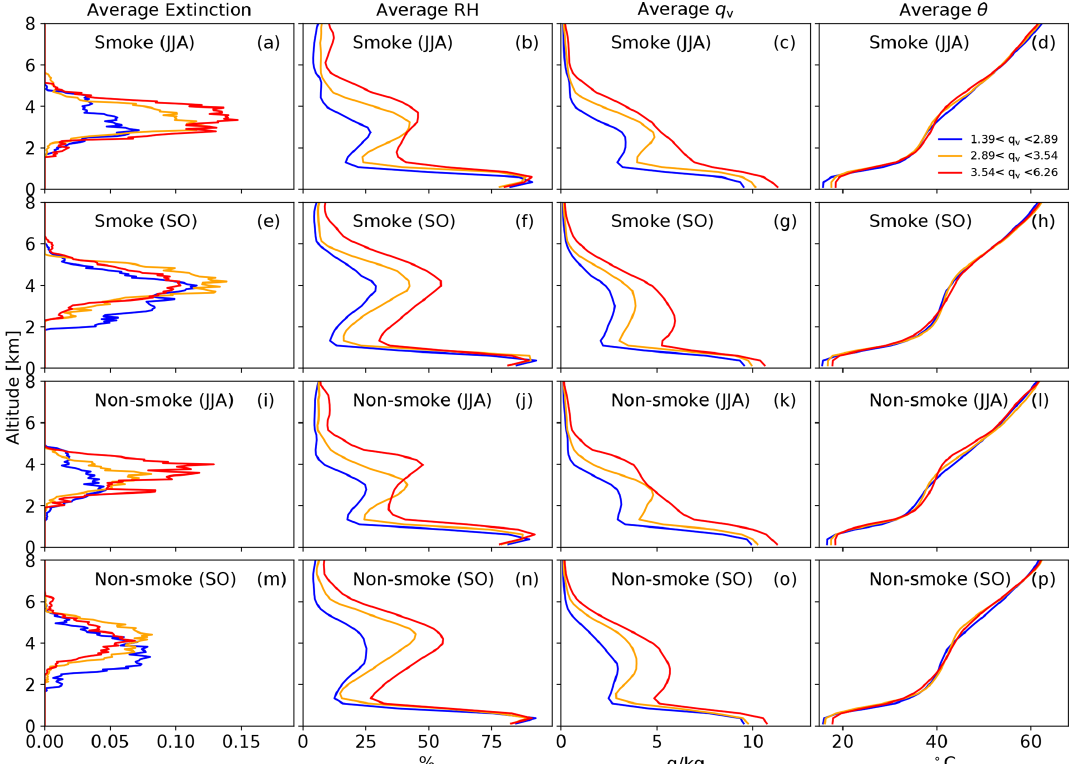
Figure A3. Mean profiles of aerosol extinction, relative humidity (RH), specific humidity ( q v ), and potential temperature ( θ ) for the smoke cases June–July–August (JJA) and September–October (SO). Cases were subdivided into three intervals as a function of the q v value. RH, q v , and θ values are derived from variables in the CloudSat ECMWF-AUX